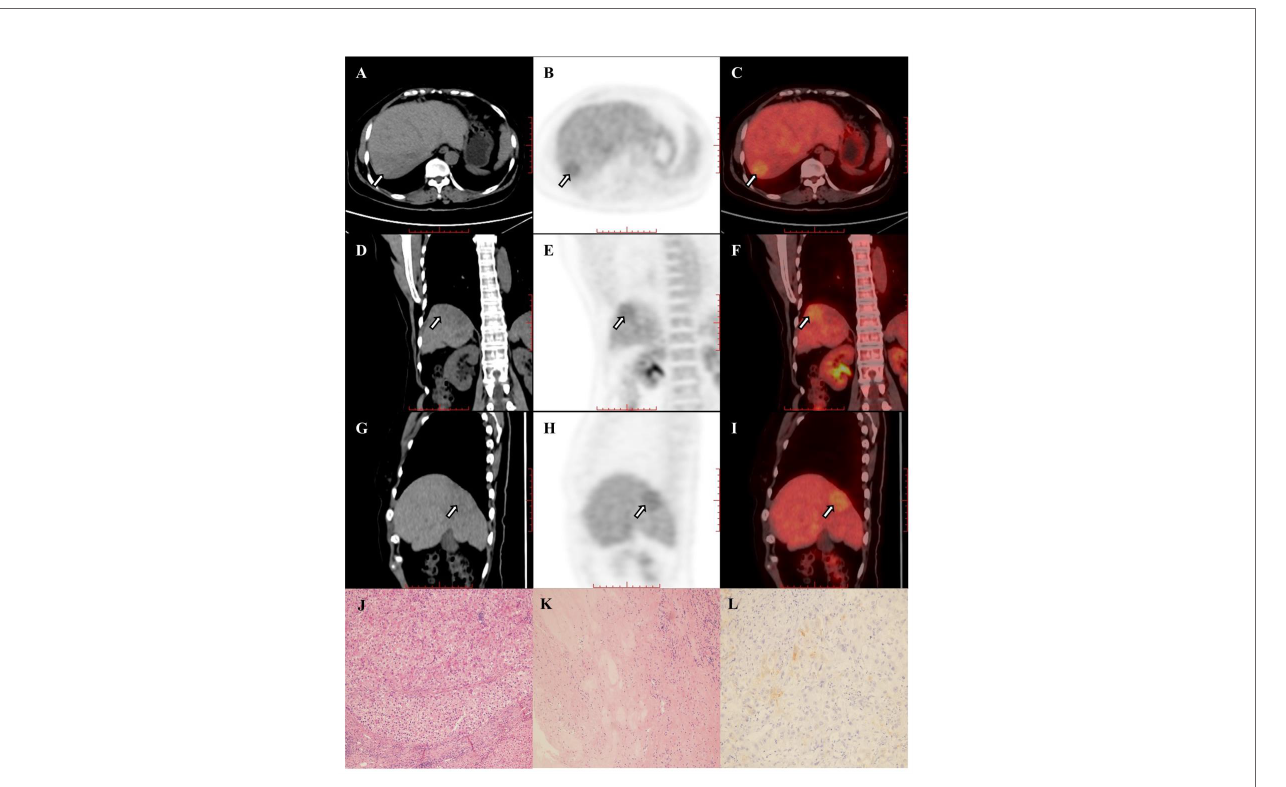
FIGURE 4A | (A – I) Images in 67-year-old woman with hepatocellular carcinoma in the right hepatic lobe (arrow), and patient was accompanied by portal vein tumor thrombus and hilar lymph node metastasis. The hepatic lesion showed low uptake (TLR=1.31). The baseline AFP was 2.19 and the Child-Pugh score was 6. The patient underwent right hemihepatectomy after 4 cycles of combination of pembrolizumab plus lenvatinib therapy. Histopathologic evaluation of response revealed bad response to therapy (residual viable tumor cellularity>90%, J – L